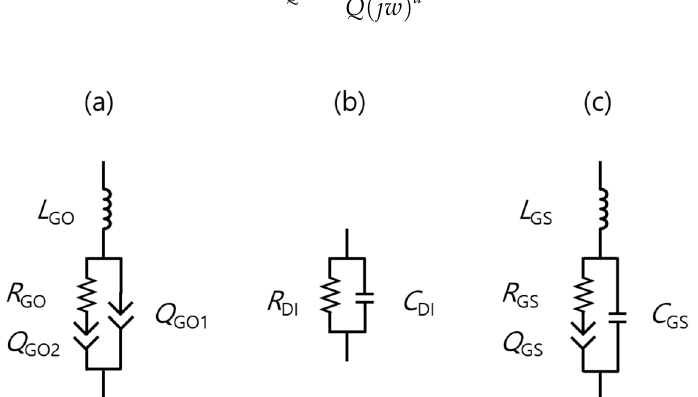
Figure 5. Equivalent circuit models: ( a ) stacked three-dimensional (3D) GO10; ( b ) de-ionized (DI), and ( c ) GS.